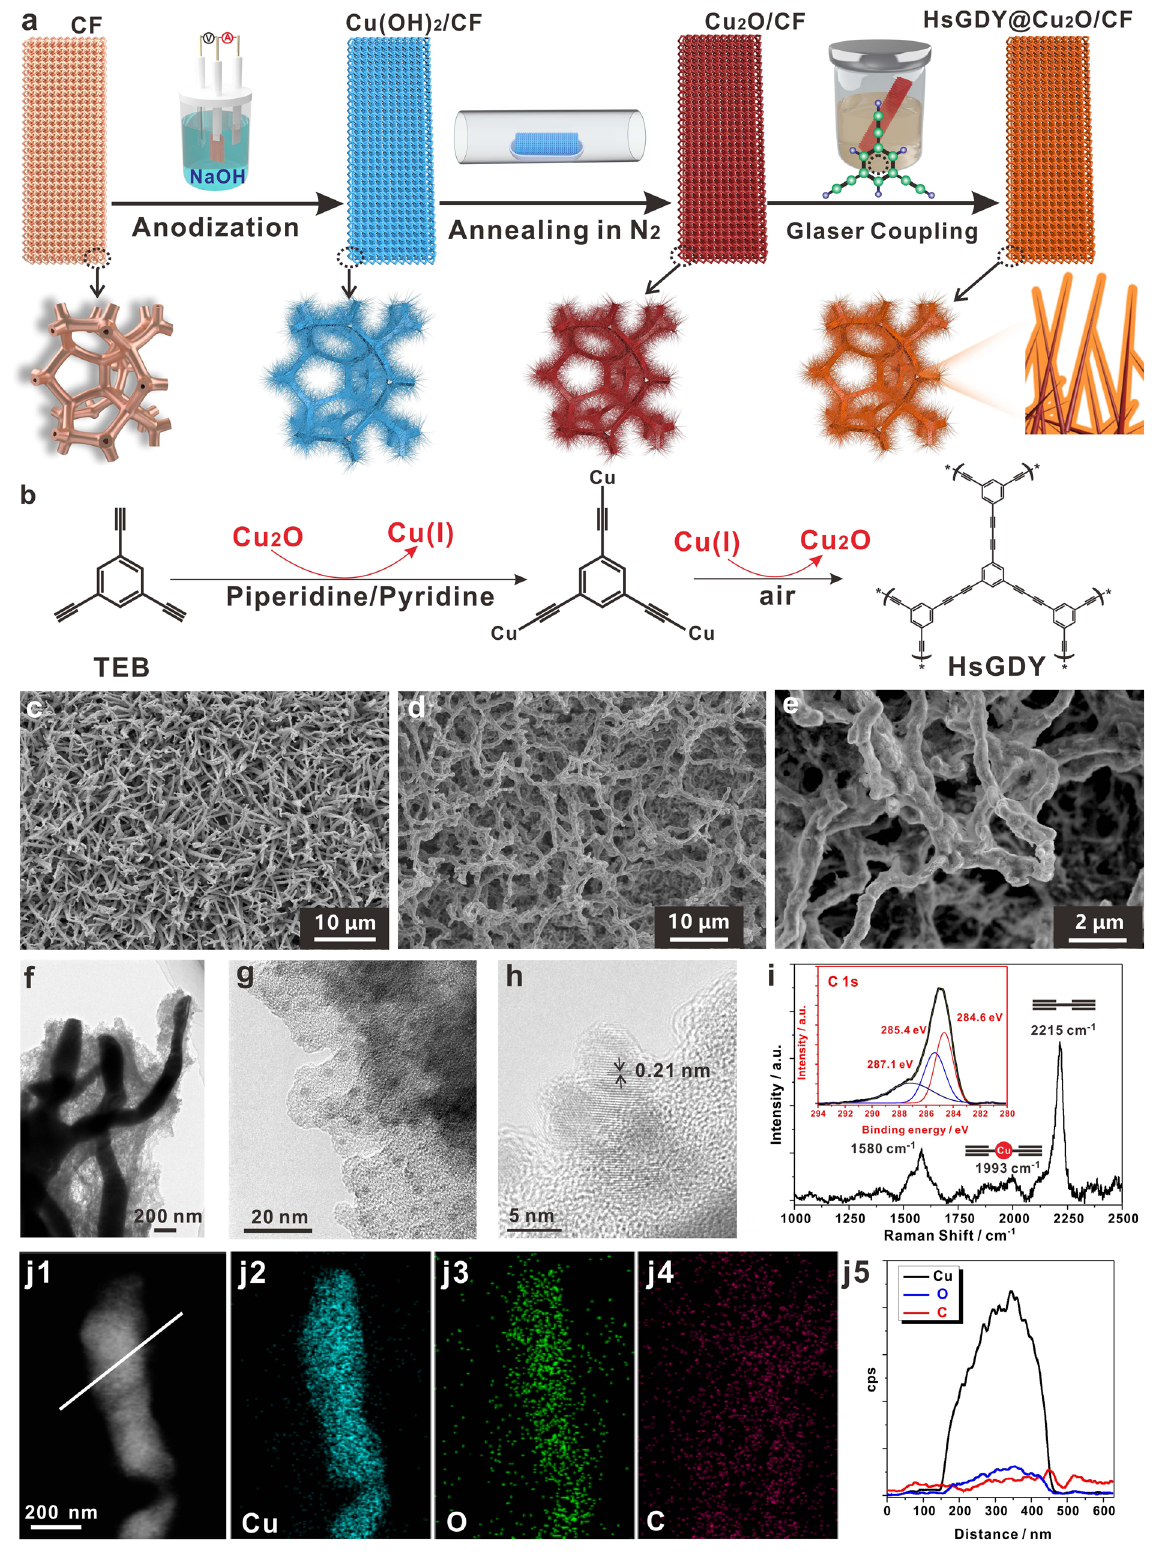
Fig. 1 | Synthesis and characterizations of HsGDY@Cu 2 O. a Schematic illustra- tion of the fabrication of HsGDY@Cu 2 O/CF photocathode; b Synthesis of HsGDY with Cu-mediated Glaser coupling reaction; SEM images of c Cu 2 O NWs and d HsGDY@Cu 2 O NWs; e Enlarged SEM image of HsGDY@Cu 2 O NWs; f TEM image